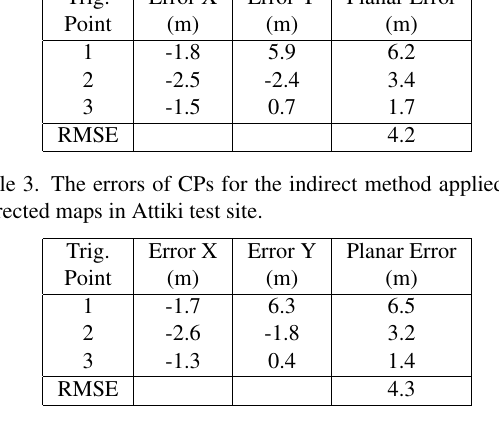
Table 4. The errors of CPs for the direct method applied to 2 corrected maps in Attiki test